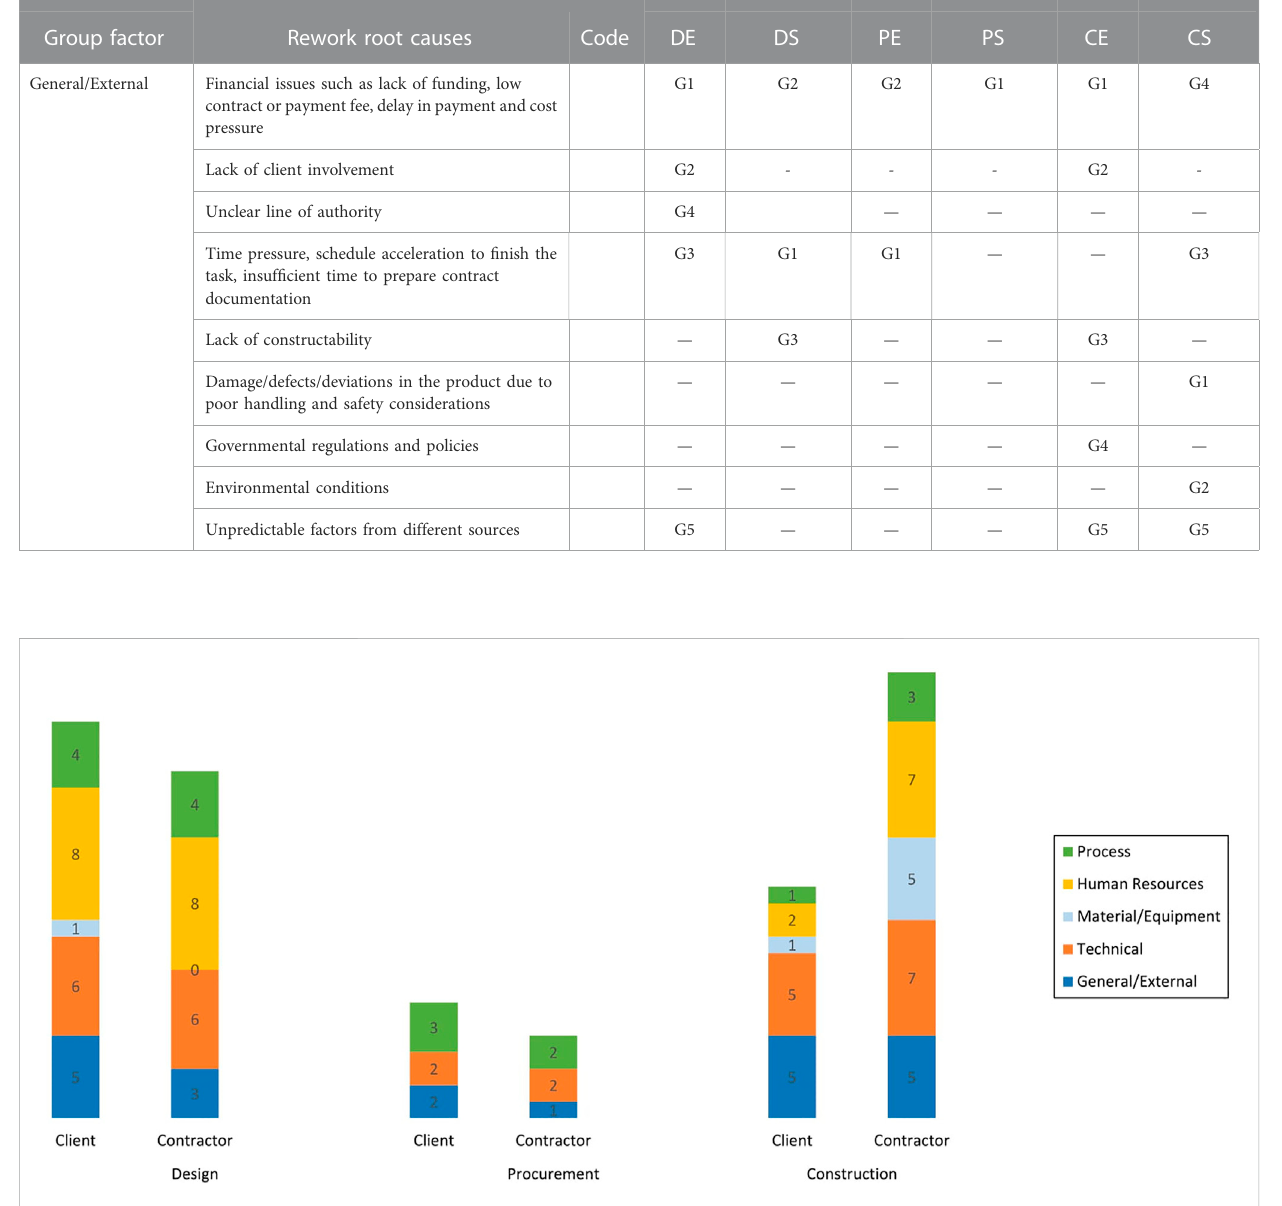
Figure 4, interest for studying causes of rework under the construction stage of a project was slightly higher than at the design stage. Both construction and design were constantly studied more than the procurement stage.